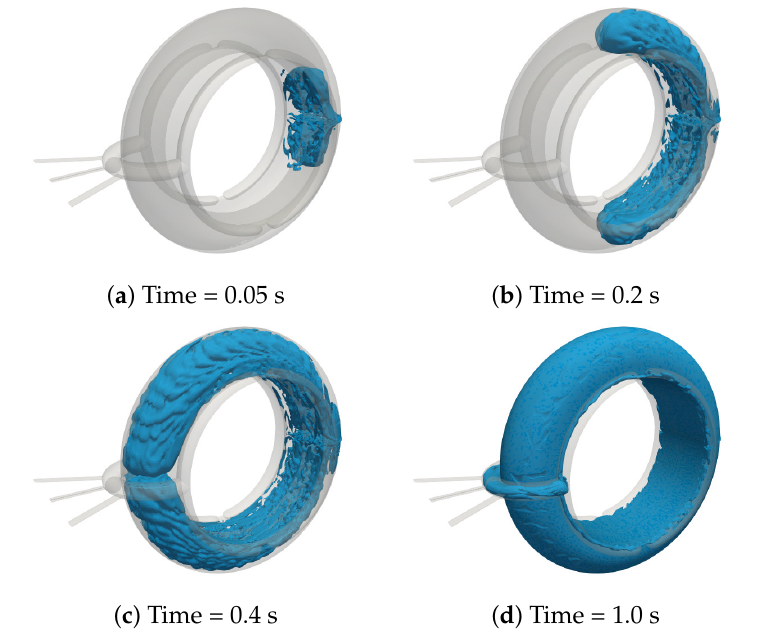
Figure 10. D-ring mould filling: Rubber front at different times, namely: ( a ) 0.05 s ( b ) 0.2 s ( c ) 0.4 s ( d ) 1